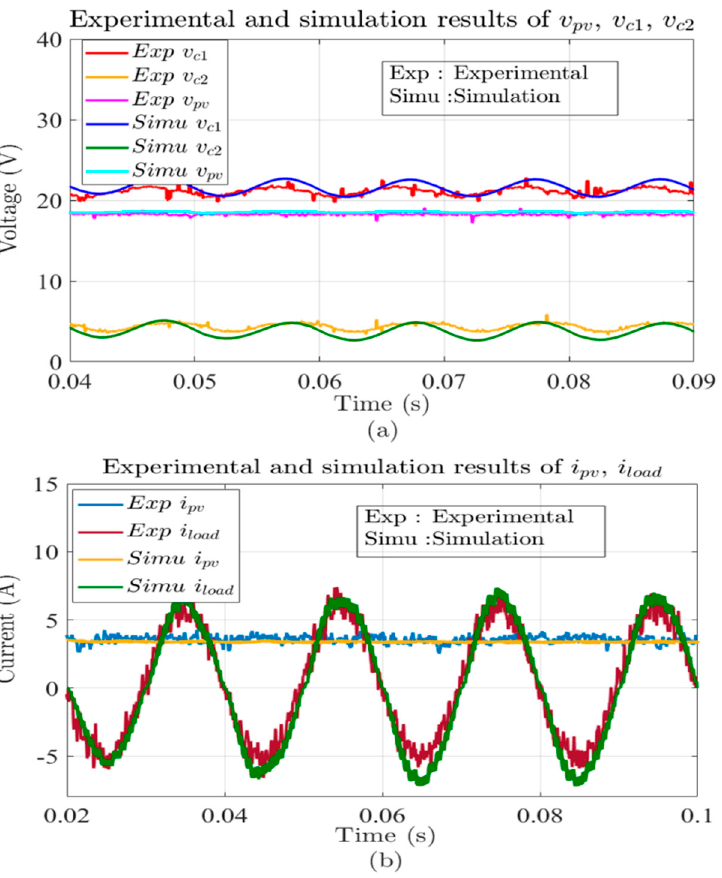
Figure 12. The experimental and simulation results ( a ) v pv , v dc , v c 1 , and v c 2 and ( b ) i pv and i load associated with case A.